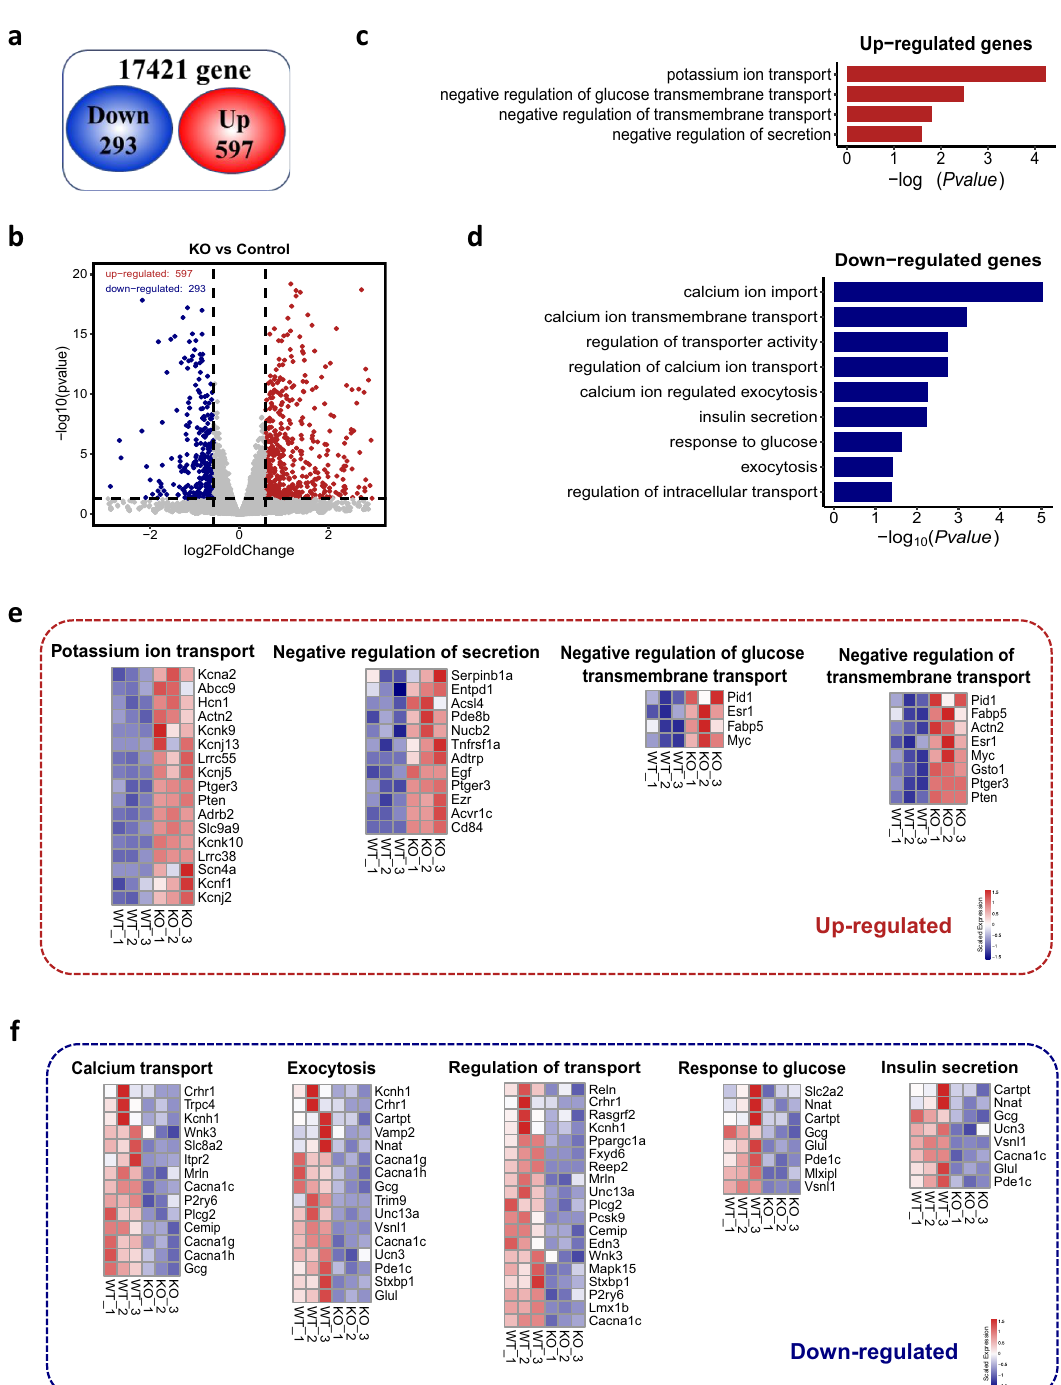
Fig. 3 Transcriptomic analysis of islets from WT and miR-21 β KO mice. a Venn diagram displaying the number of statistically signi fi cant altered gene s in the islets from miR-21 β KO mice ( n = 6). b A volcano plot of differentially expressed genes. The vertical lines represent 1.5-fold increased and decreased expression. The horizontal line shows P = 0.05. Blue and red dots indicate genes with statistically signi fi cant differential expression. c , d Representative biological processes up-regulated ( c ) and down-regulated ( d ) in the islets from miR-21 β KO mice were characterized using GO enrichment analysis. e , f Representative genes up-regulated ( e ) and down-regulated ( f ) were illustrated using heatmap. Each column represents data from pooled islets of two mice. Equal numbers of male and female mice were used in two genotypes. Source data are provided as a Source Data fi le.